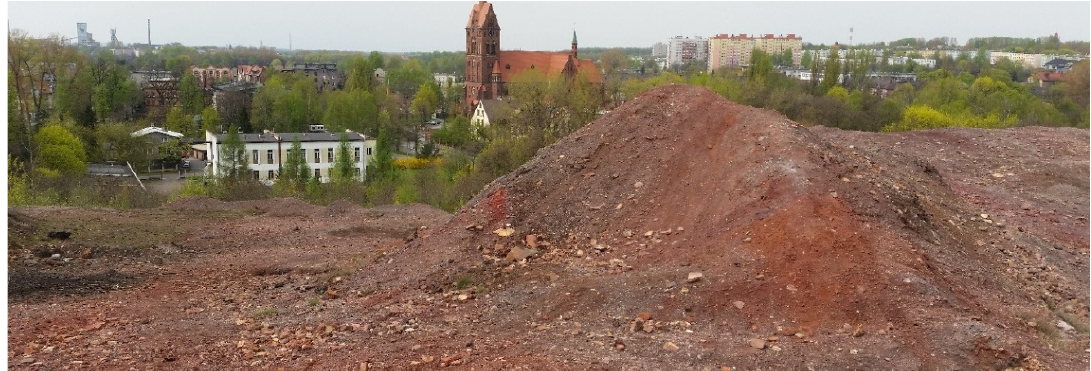
Figure 1. Landscape of an exposed heap in the center of the city of Ruda Ś l ą ska.